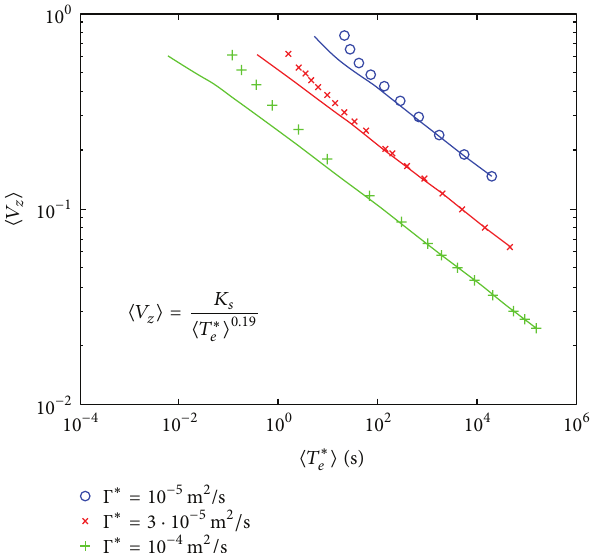
Figure 5: Average settling velocity of particles initially situated inside an inclined vortex versus the average permanence time for = 0.001 m, various values of the circulation of the vortex, and 𝑅 ∗ V the values for the diameter of the particles as in Figure